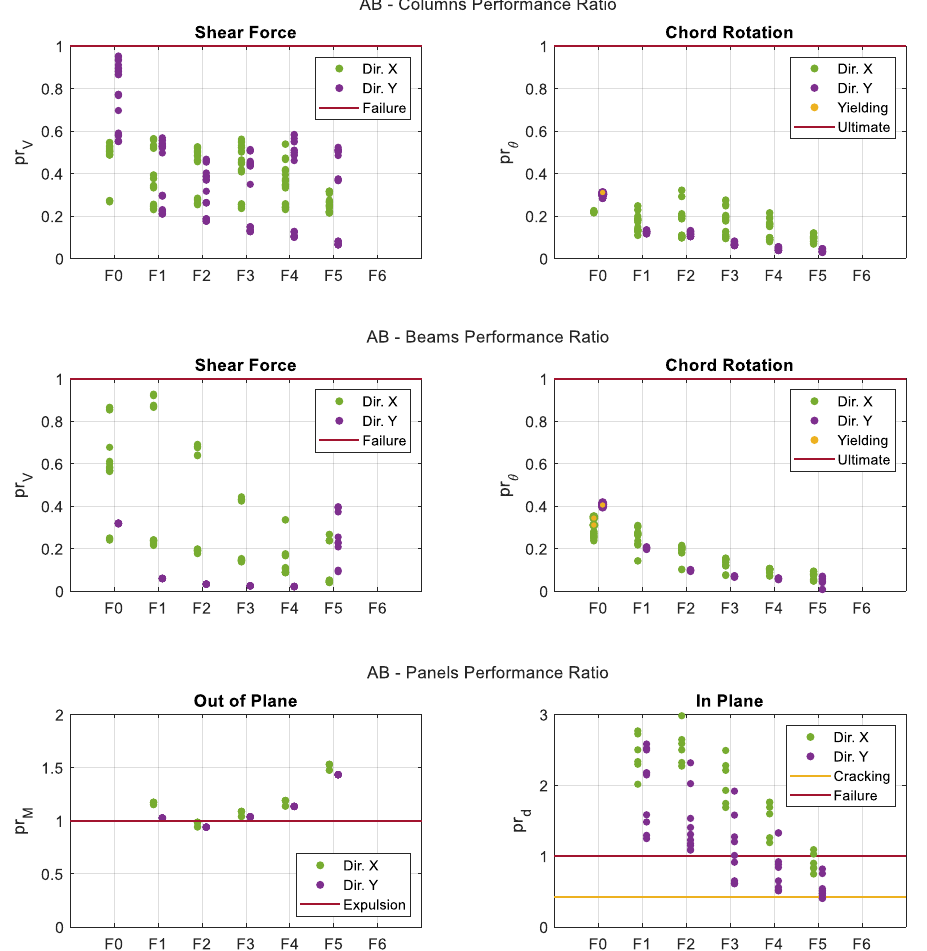
Figure 11. As-Built RC elements and infill panels performance ratios.